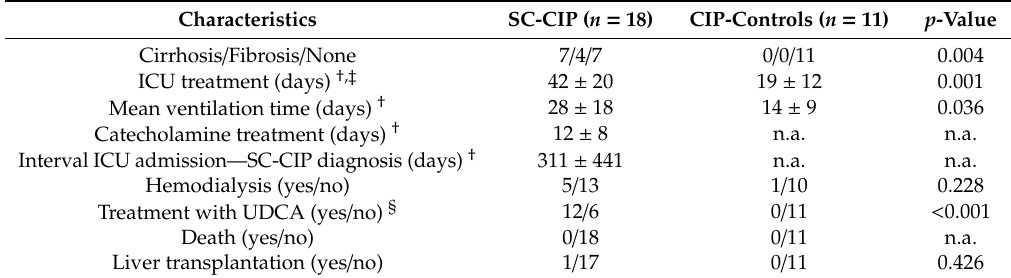
Table 2. ICU treatment and disease characteristics for Secondary Sclerosing Cholangitis in Critically Ill Patients (SC-CIP) and patients after critical illness without liver disease (CIP controls). Characteristics